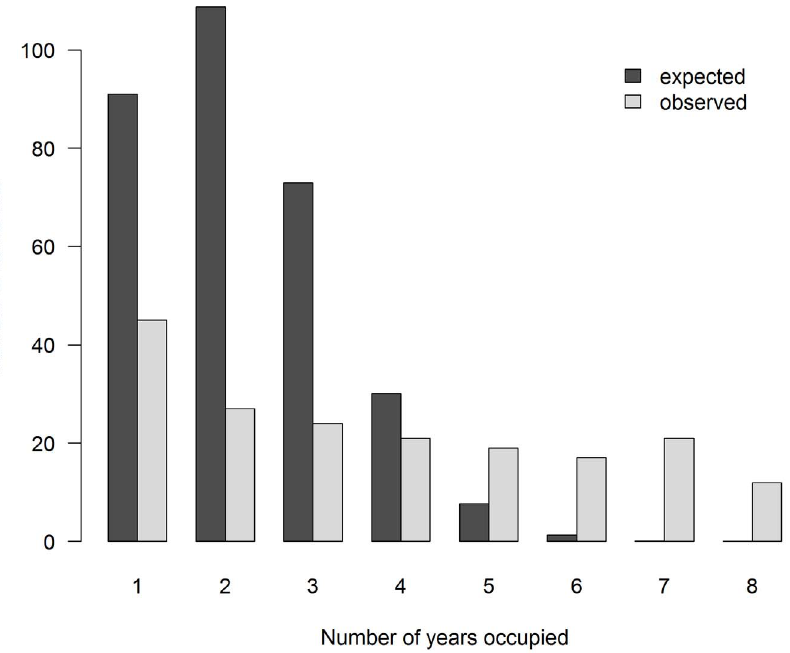
Figure 1. Observed and expected frequency of territory occupancy. The comparison of observed and expected (according to a random selection scenario) frequency of territory occupancy of hoopoes (2002–2009) shows the deviation from a random territory selection pattern ( x 2 =117.85, df=7, P , 0.001).